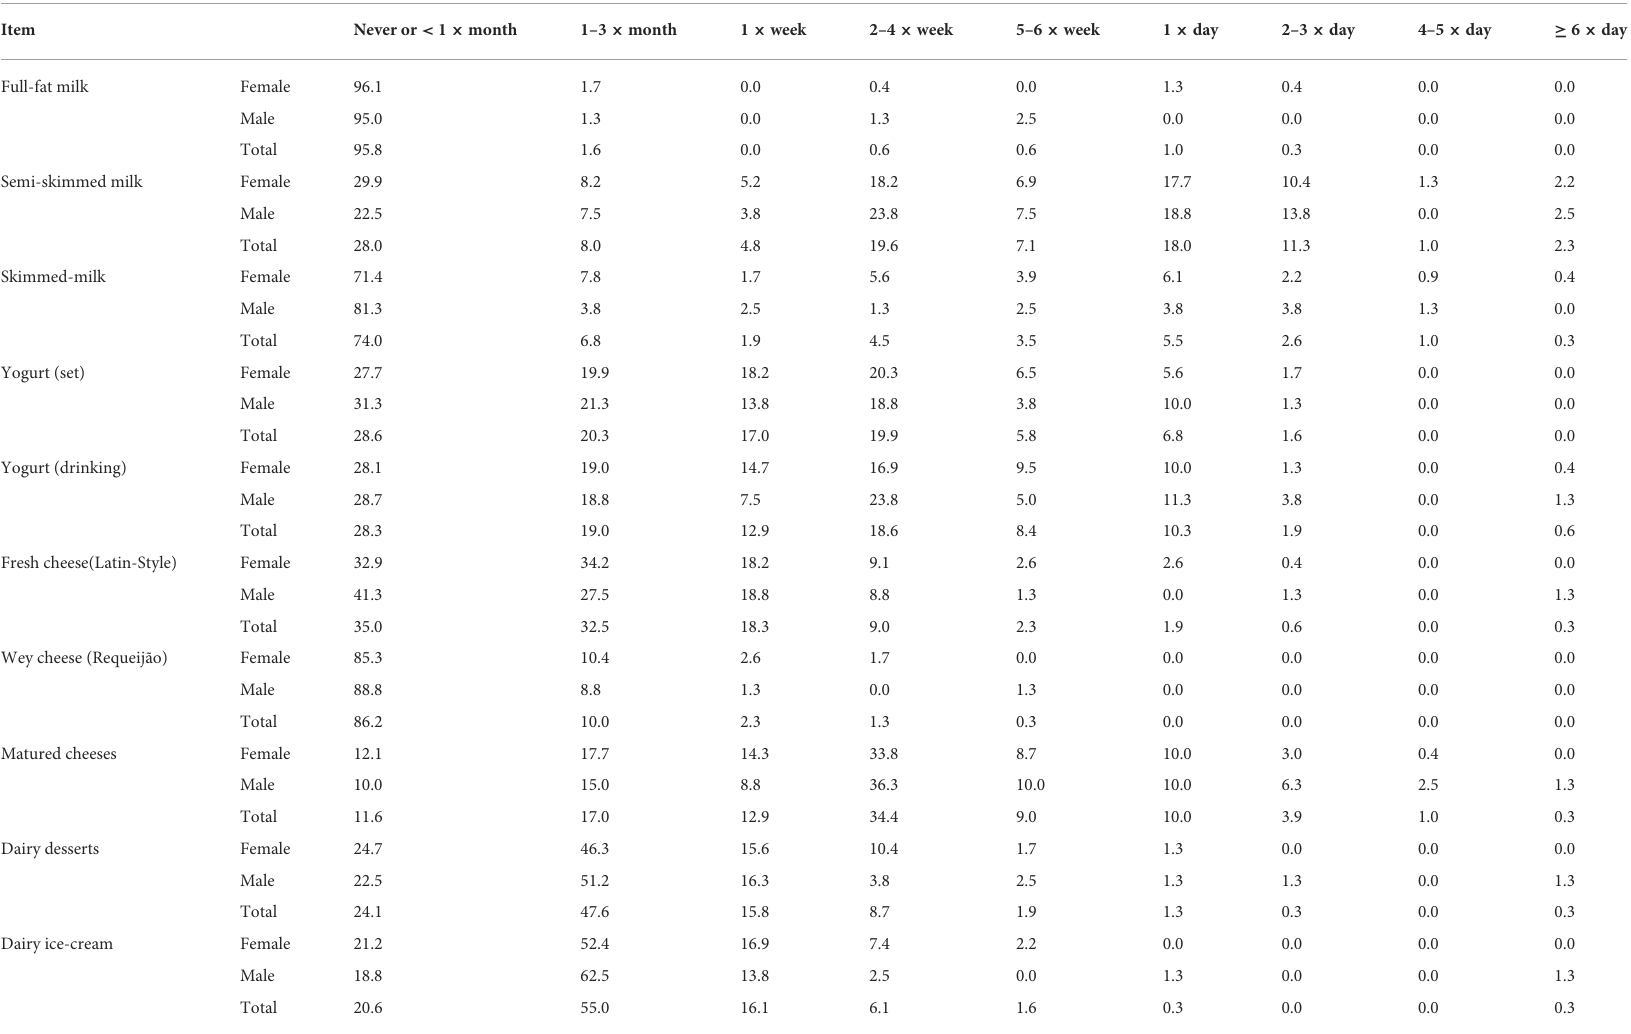
TABLE 1 Frequency of consumption of dairy products among Azorean university students [ n = 311, female = 231, male =